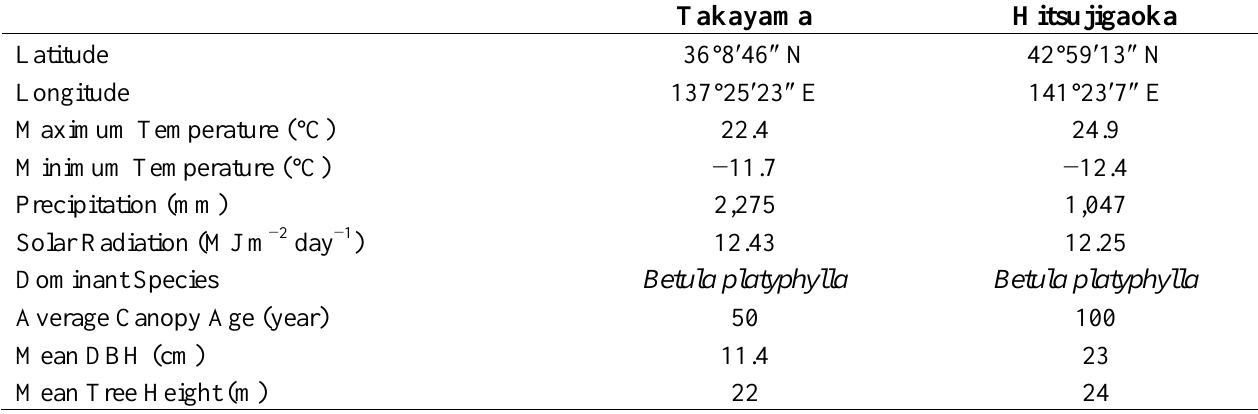
Table 2. Summary of the site description at Takayama and